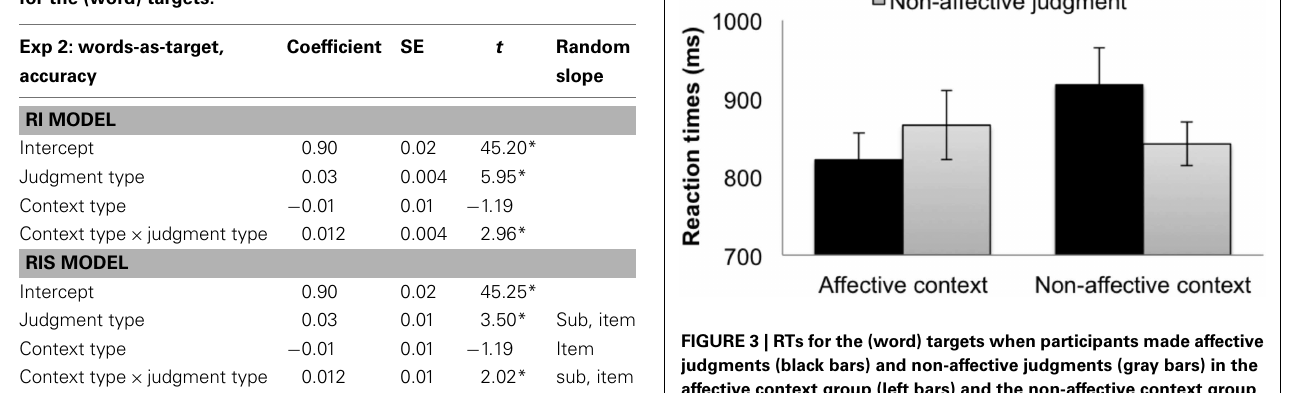
Table 2 |The linear mixed-effects regression models on the accuracies for the (word) targets.